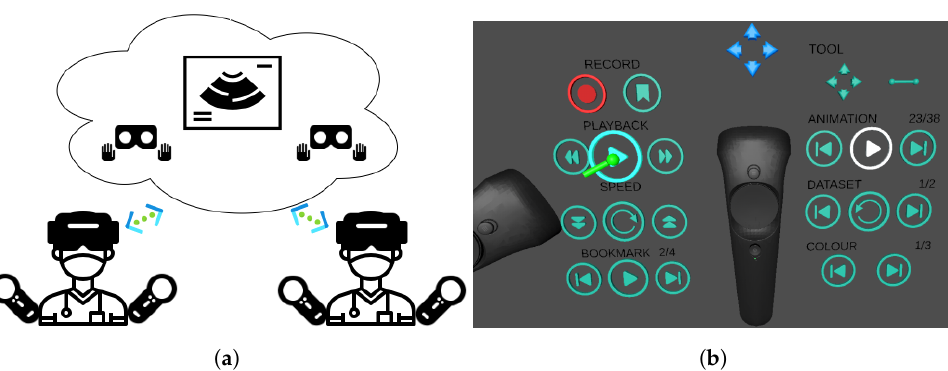
Figure 3. Multiuser features. ( a ) Representation of synchronous collaborative planning, where two users simultaneously interrogate the data remotely. Each user sees the other users by their virtual avatar. ( b ) Interface for asynchronous collaboration, where one user can play back an interrogation session previously carried out by another user. The playback is a single-player feature who can toggle the display of the avatar who performed the recorded